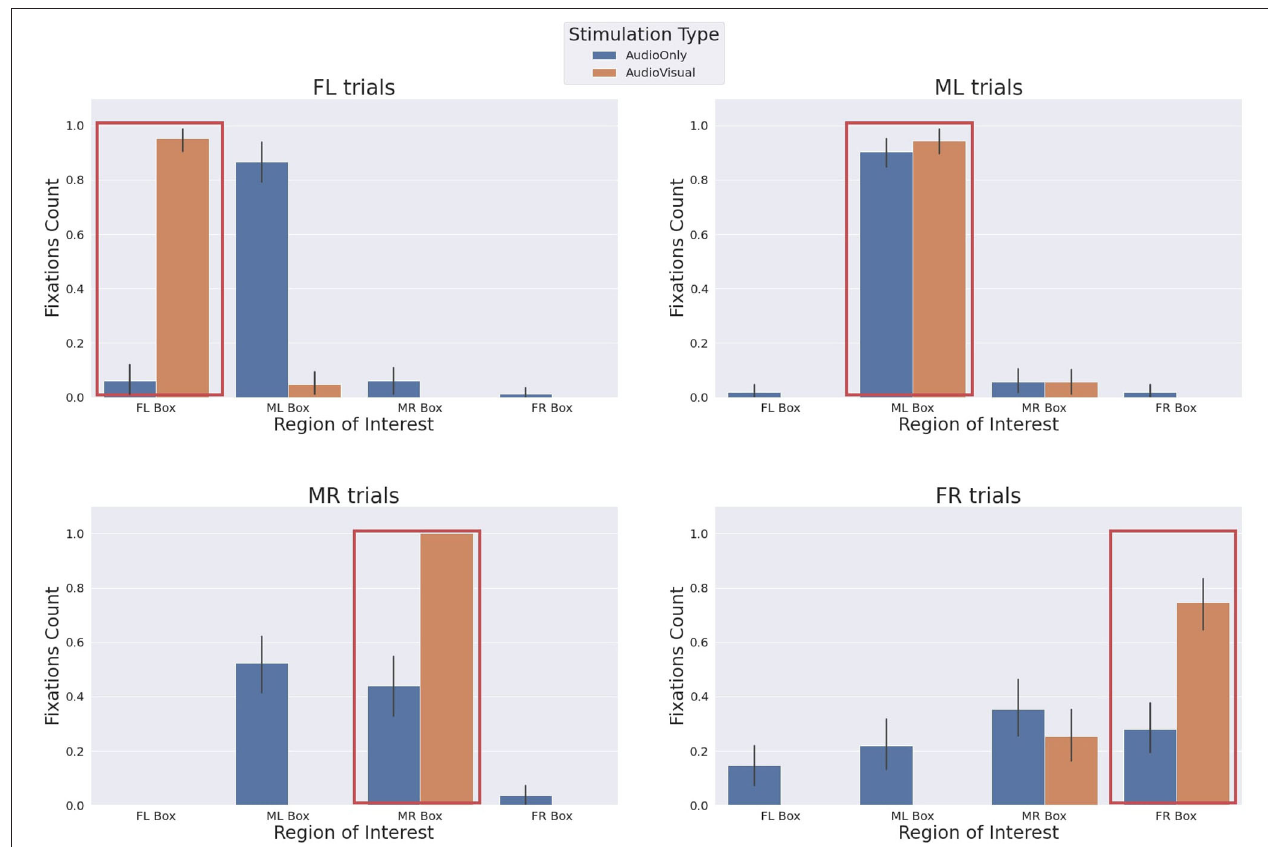
FIGURE 14 | The gaze behaviour of the